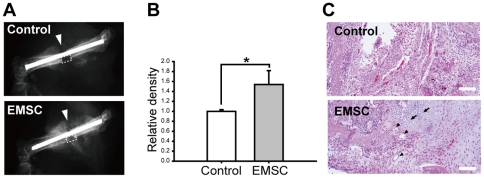
Repair of bone fracture in mice after transplantation of EMSCs.(A) Fracture healing was assessed by X-ray after 14 days with or without EMSCs (at the fifth passage) transplantation. Arrowheads indicate the site of fracture. (B) The bone density of fracture site (dotted box in Figure 8A) was quantified (n = 4). EMSCs transplantation significantly improved osteocalcification as compared to the control group. (C) The morphology of fracture sites were examined by H&E staining. Tissue disorganization was showed in the control group while the EMSCs transplanted group newly formed bone tissue (arrow) and capillaries (arrowhead). * represents P<0.05. Scale bars represent 100 µm. Data are presented as mean ± s.d. and analyzed with Student's t-test. Control: SPONGOSTAN carried with complete medium-transplantation group; EMSC: SPONGOSTAN carried with EMSCs-transplantation group.